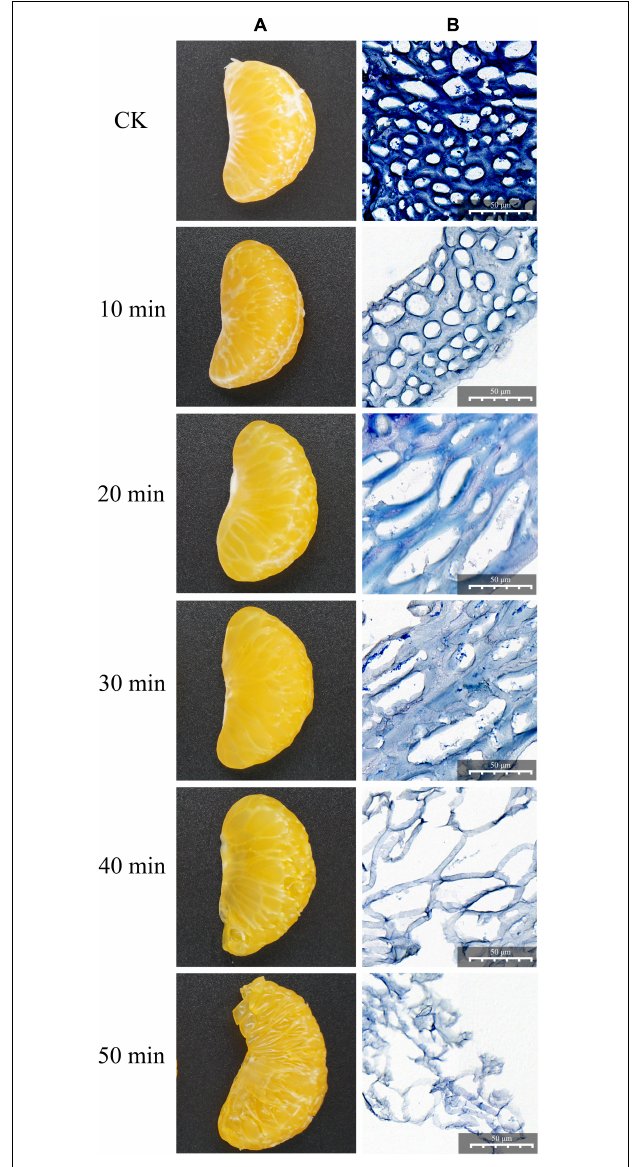
FIGURE 1 | Degradation effect of the crude enzyme solution on citrus segments at different time points. (A) Macroscopic observation. (B) Microscopic observation by light